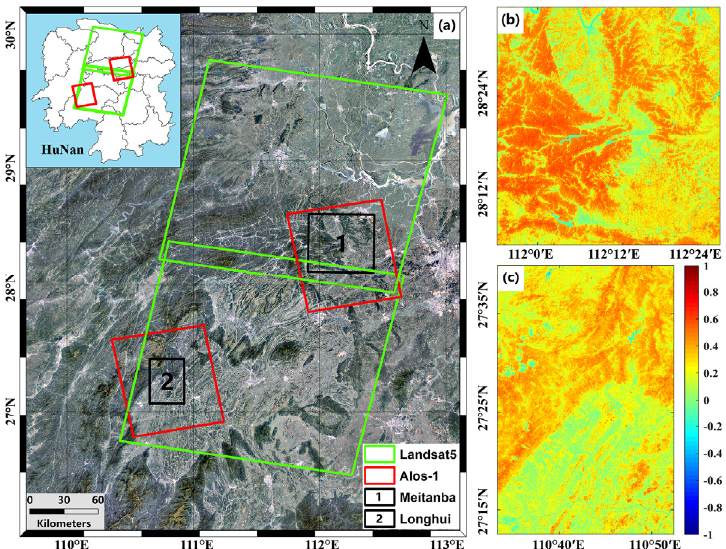
Figure 1. ( a ) Optical image of the study area. Green and red rectangles represent the coverages of Landsat5 and ALOS-1/PALSAR-1 images, respectively. Black boxes indicate the locations of Meitanba and Longhui areas. ( b ) NDVI image of the Meitanba area; ( c ) NDVI image of the Longhui area.